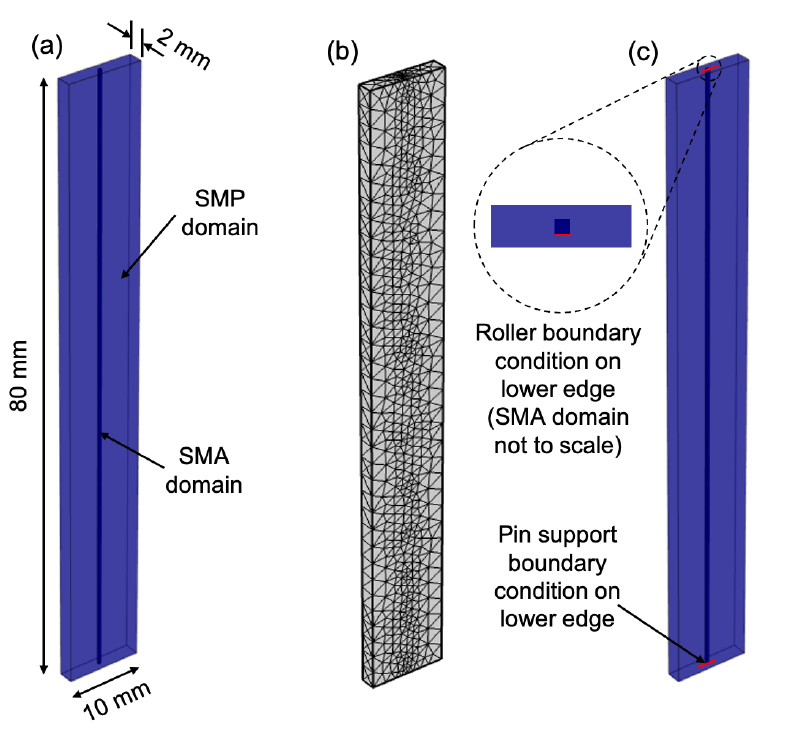
Figure 7. ( a ) Overall dimension of the COMSOL geometry with the SMA domain modelled as a wire having a square cross-section of 0.31 mm × 0.31 mm, ( b ) physics-controlled mesh, and ( c ) roller boundary condition at one end and the pin support boundary condition at other end of the SMA